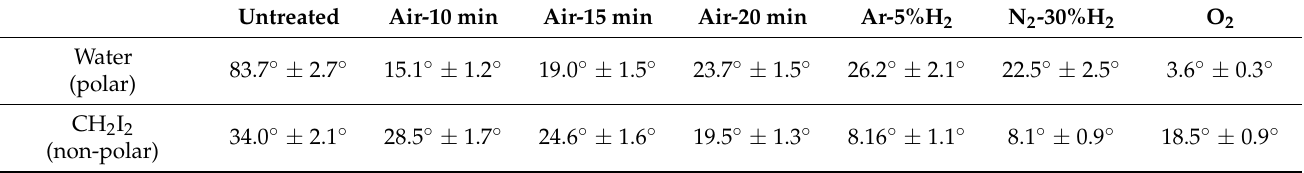
Table 2. Contact angle